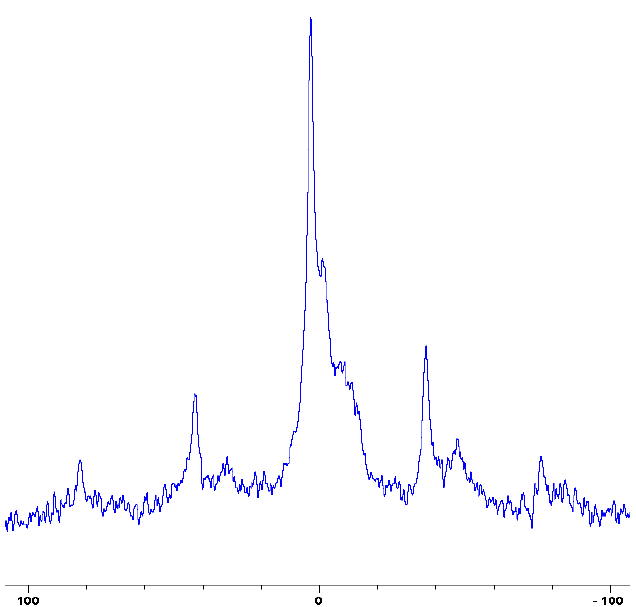
Figure 1. Solid-state 31 P-NMR spectrum of char obtained from fish gelatin + triphenylphosphine (TPP) (the abscissa denotes the chemical shift values, δ , in ppm and the ordinate corresponds to the signal intensity in arbitrary units).